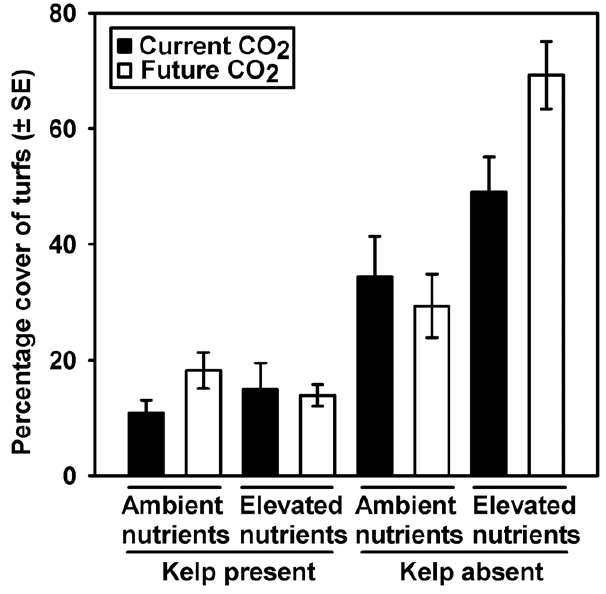
Figure 2. The final percentage cover of turf-forming algae that were transplanted from ambient conditions (as defined in Figure 1) to different combinations of Kelp (present v. absent), Nutrients (ambient v. elevated) and CO 2 (current v. future).